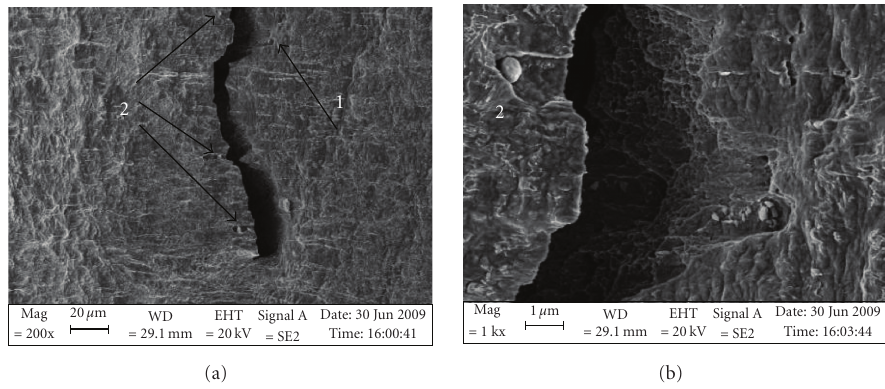
Figure 6: Macro-crack formation and magnified picture after the stretches.